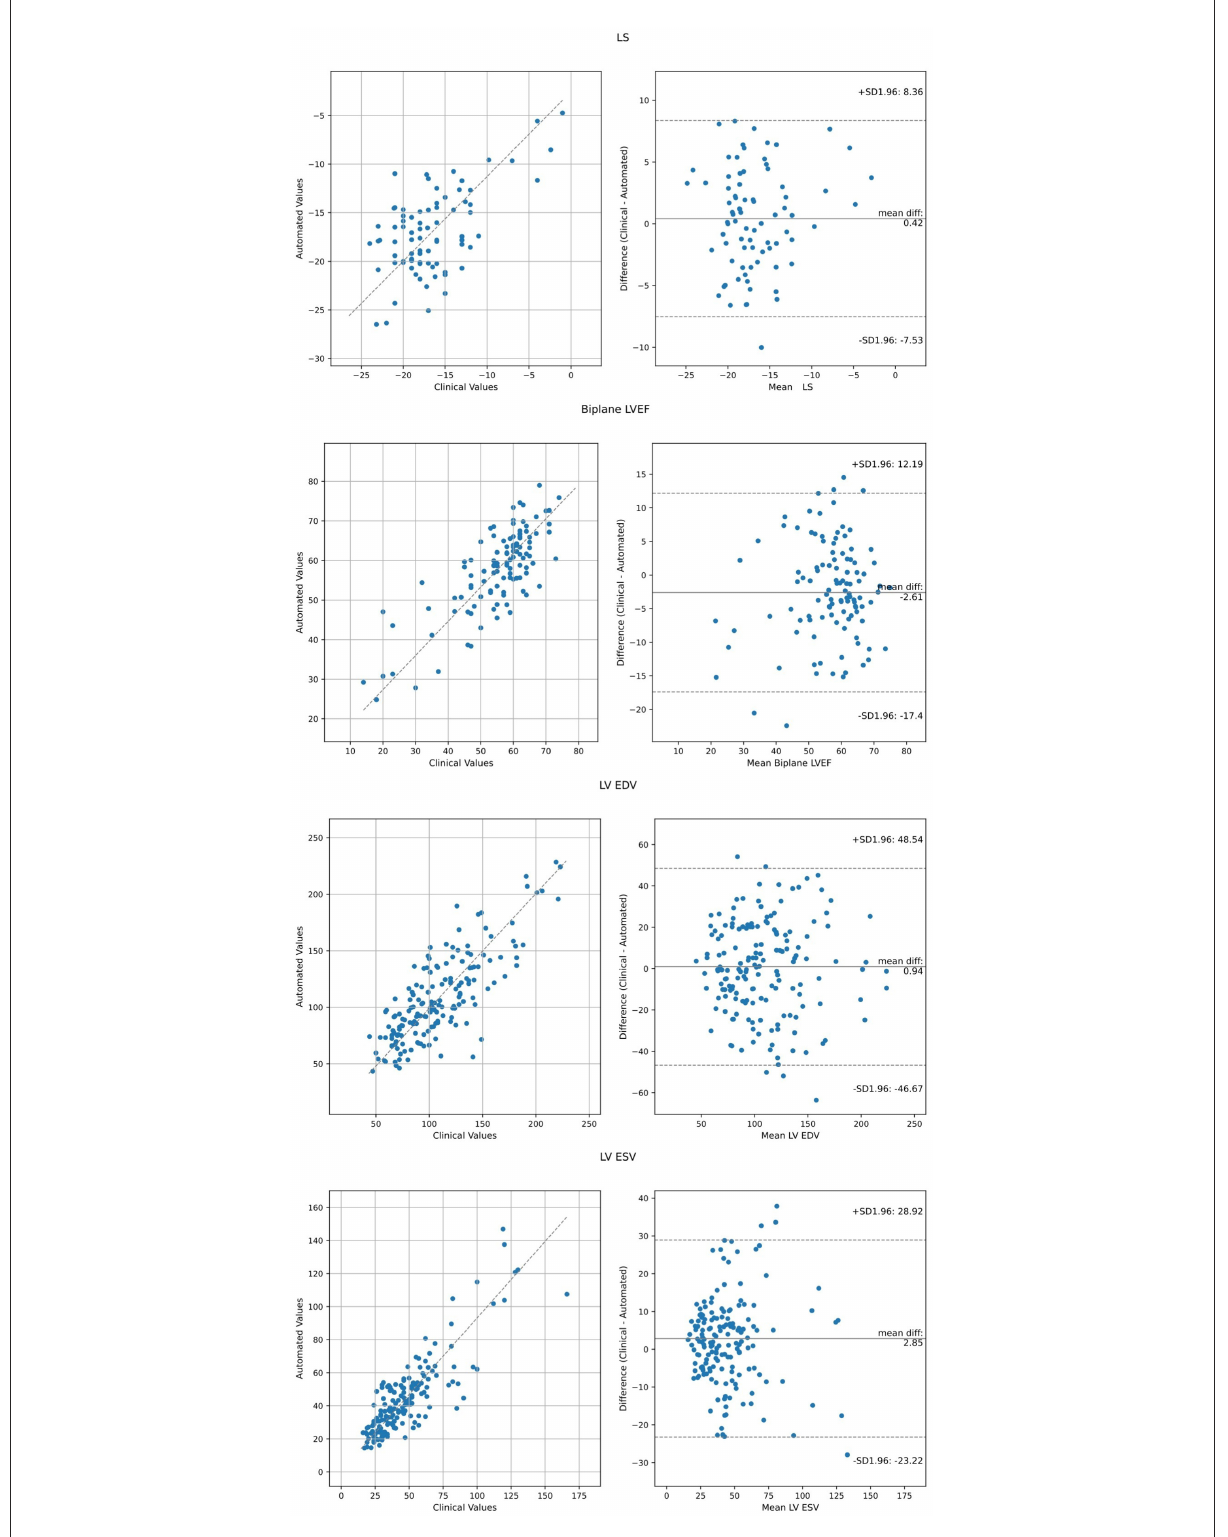
FIGURE1 Agreement analysis between automated metrics of LV function relative to clinically derived values using Bland Altman analysis and Deming Regression. LVEF and LS values represent all available data, including biplane and single plane (either apical 4- or